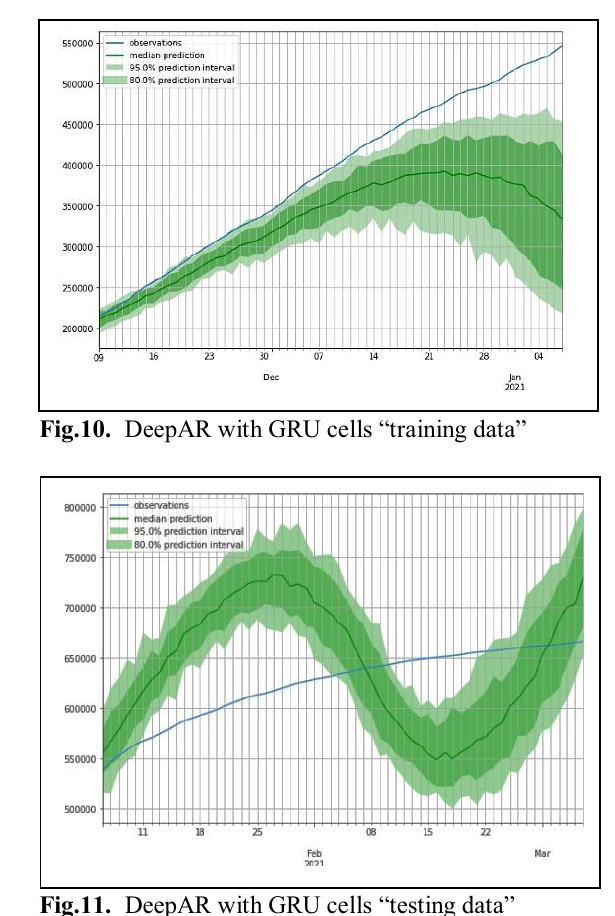
Fig.9. DeepAR with LSTM cells “testing data”